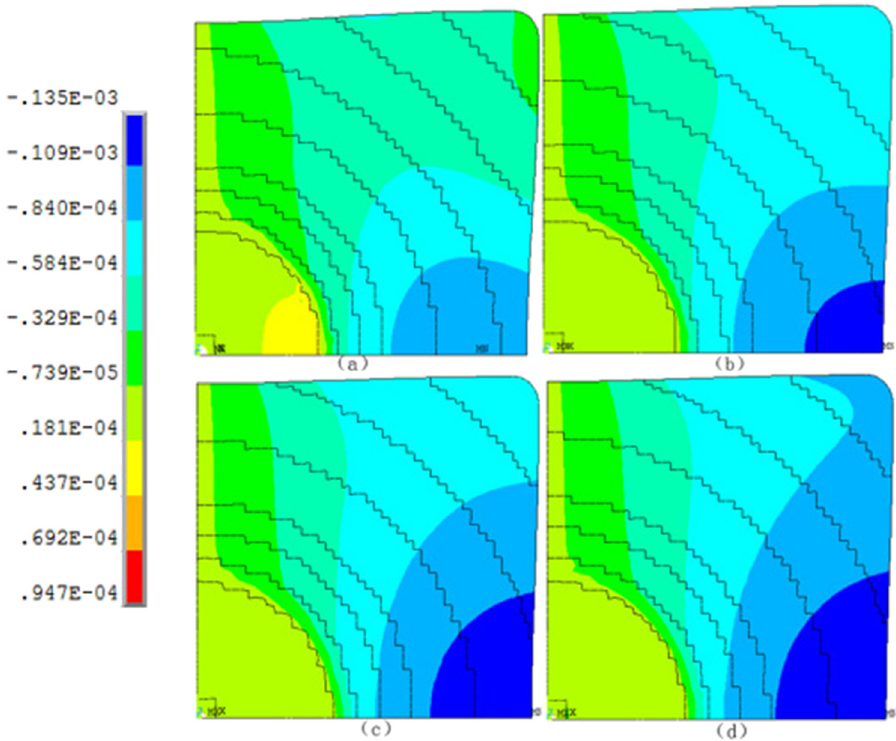
Figure 3: Cloud diagram of displacement distribution under di ff erent casting speeds: ( a ) 1.6 m · min − 1 , ( b ) 2.0 m · min − 1 , ( c ) 2.4 m · min − 1 , and ( d ) 2.8 m · min − 1